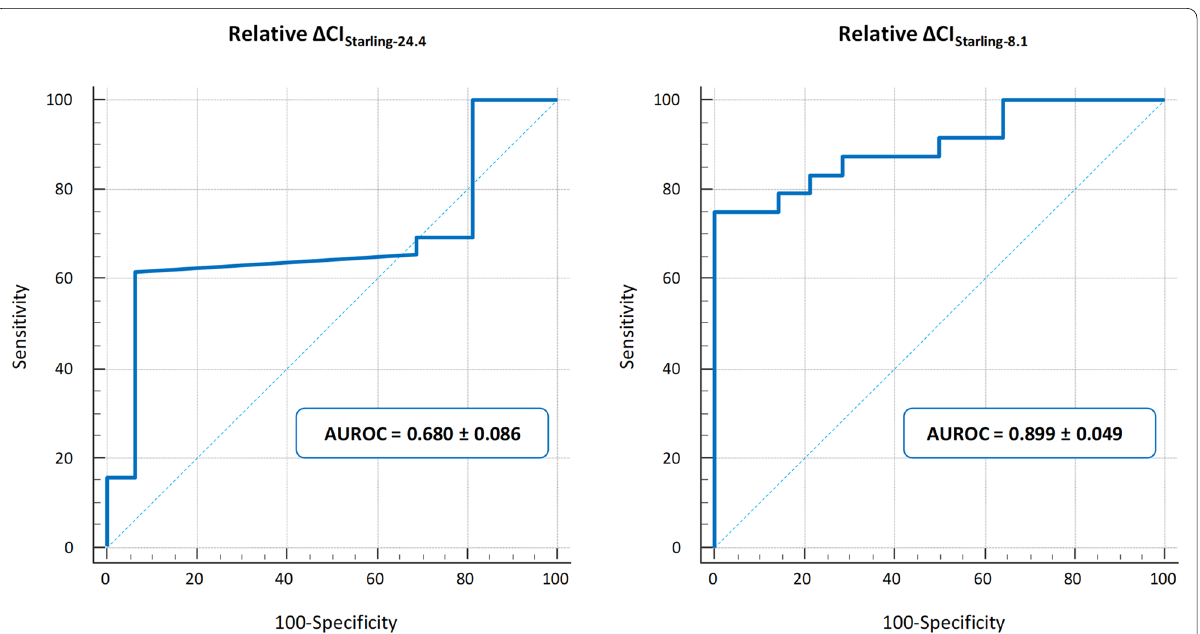
Fig. 2 Ability of relative ΔCI Starling‑24.4 (left) and ΔCI Starling‑8.1 (right) to detect preload responsiveness at the EEXPO test. AUROC: area under the receiver operating characteristic curve; EEXPO: end‑expiratory occlusion; ΔCI Starling‑24.4 : changes in cardiac index detected by the commercial version of the Starling device (averaging time 24 s, refresh time 4 s); ΔCI Starling‑8.1 : changes in cardiac index detected through raw data analysis of the Starling device (averaging time 8 s, refresh time one